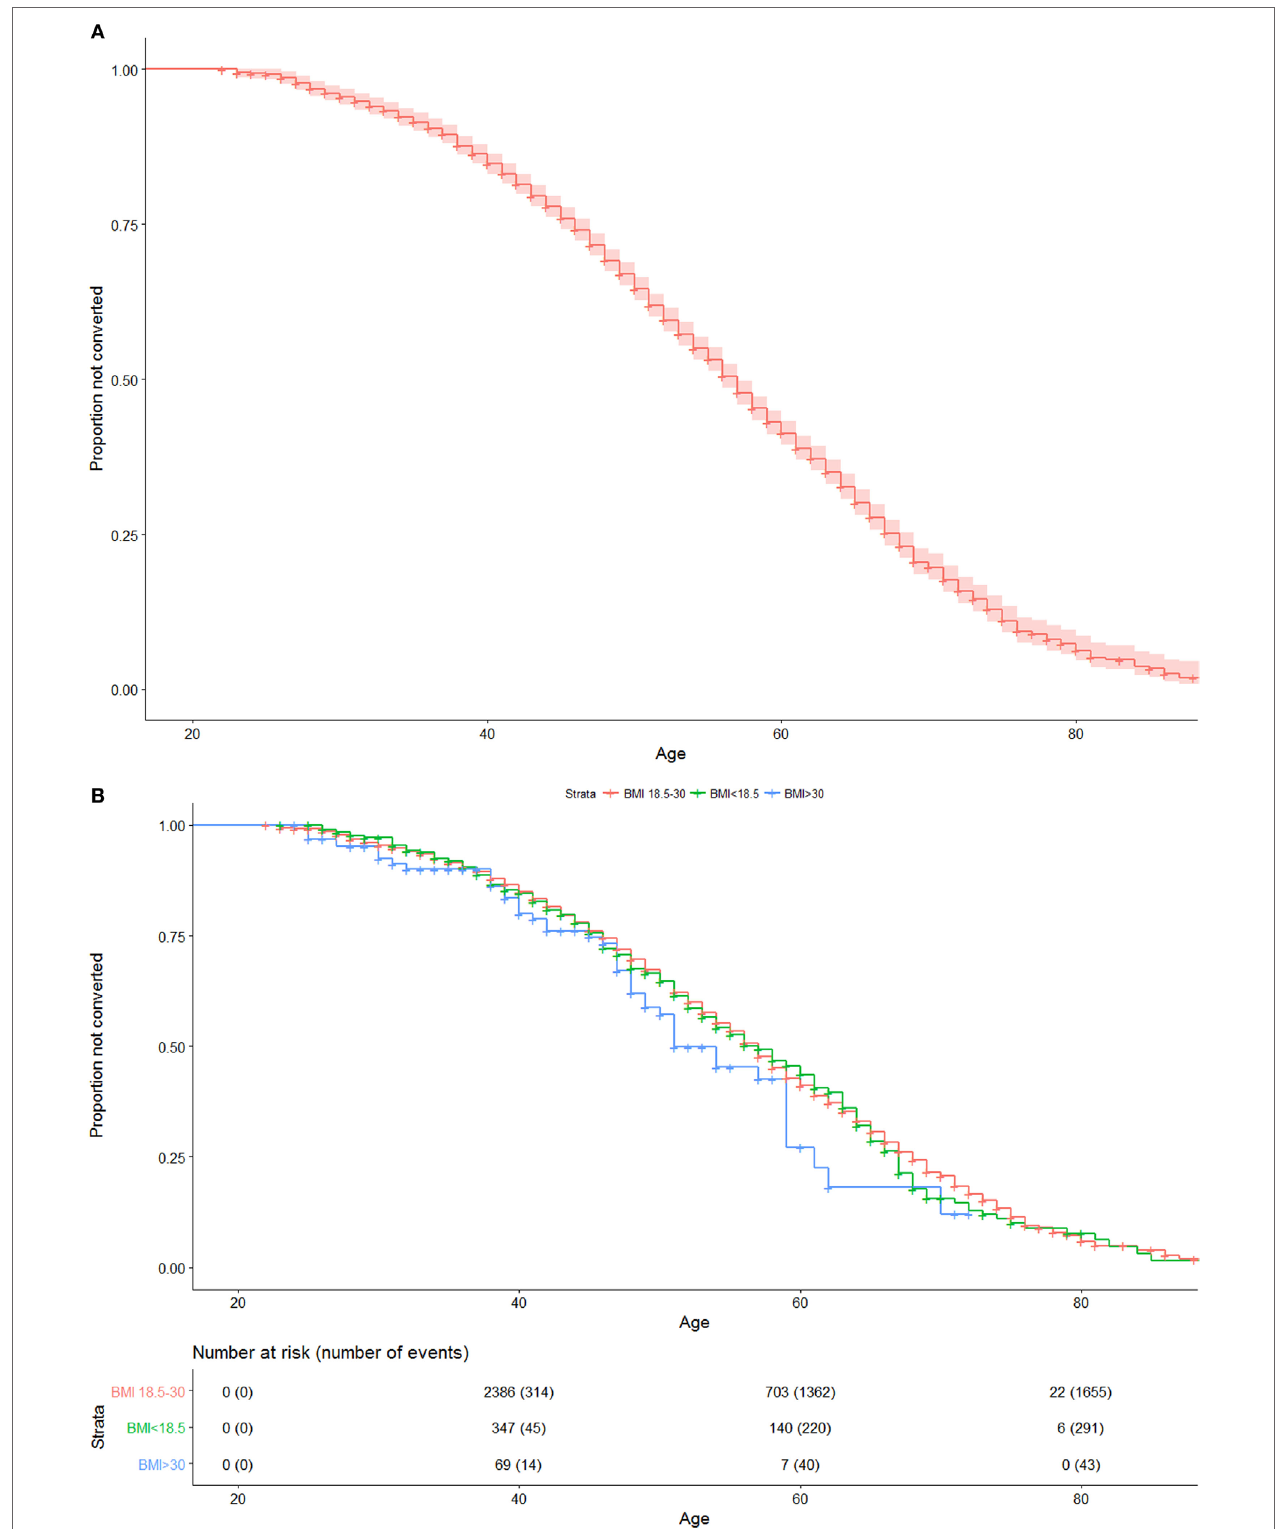
FigUre 1 | (a) Uncorrected Kaplan–Meier plot of conversion to SPMS of entire cohort. Numbers at risk and cumulative numbers of events are presented. (B) Uncorrected Kaplan–Meier plot of conversion to SPMS of entire cohort, when stratified by body mass index ( < 18.5, 18.5–30, > 30). Numbers at risk and cumulative numbers of events are